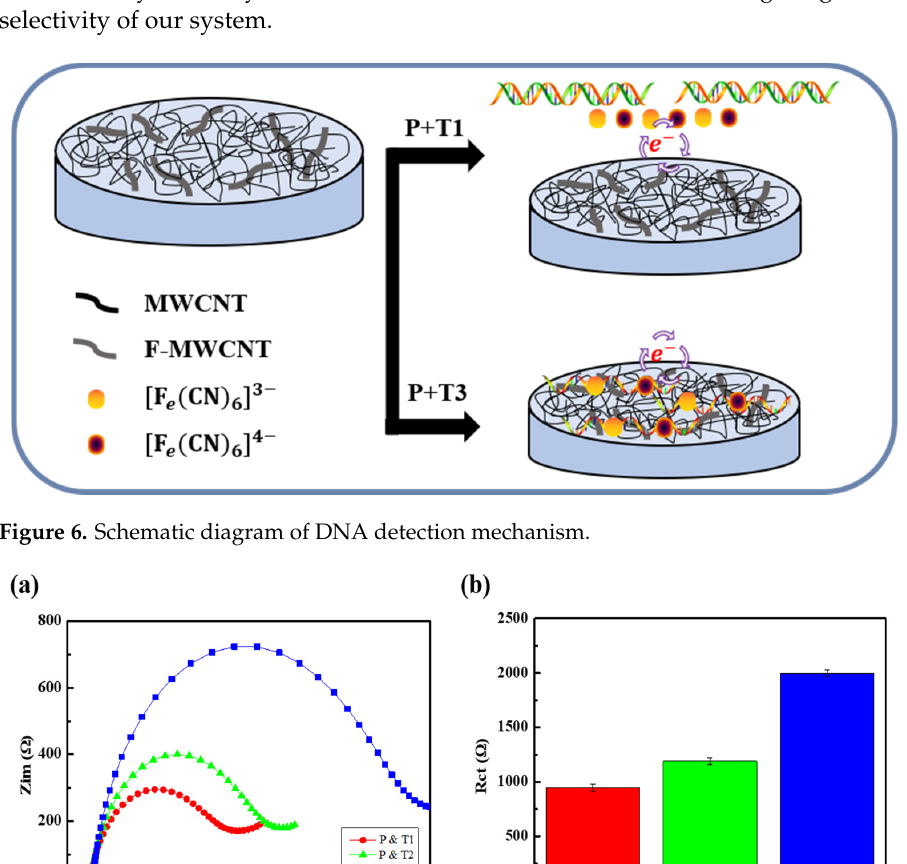
Figure 7. ( a ) Nyquist plots and ( b ) R ct values for 1 nM probe DNA and 1 nM target DNA (T1, T2 and T3) in 4 mM [Fe(CN) 6 ] 3 − /4 − solution with 1 × PBS buffer (pH = 7.4).